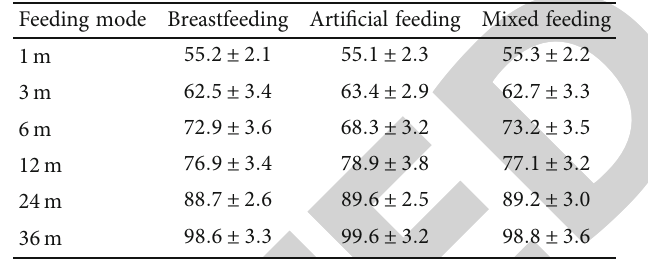
Table 1: E ff ects of feeding methods in di ff erent periods on height development ( (cid:1) x ± s, cm).